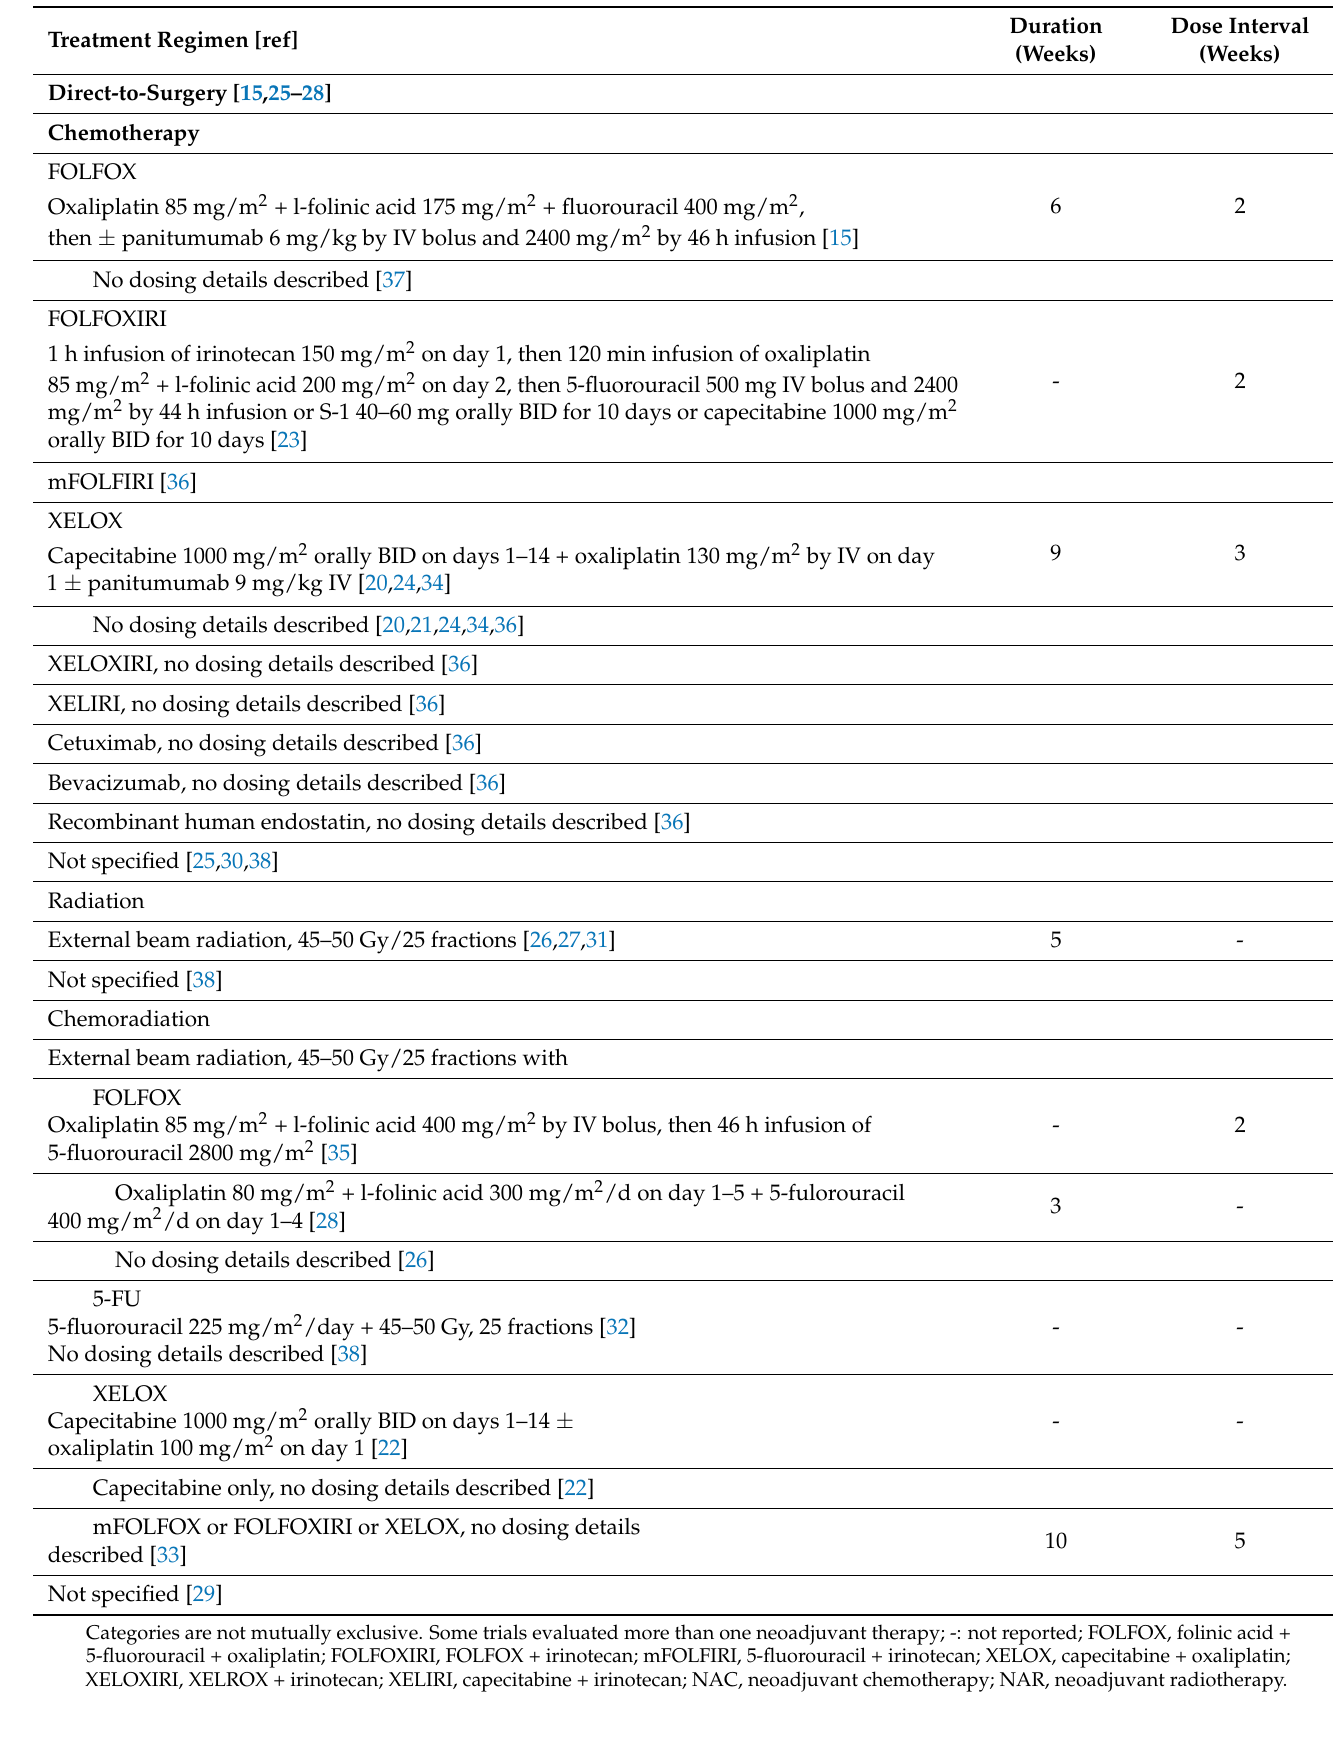
Table 2. Neoadjuvant regimens as detailed by included